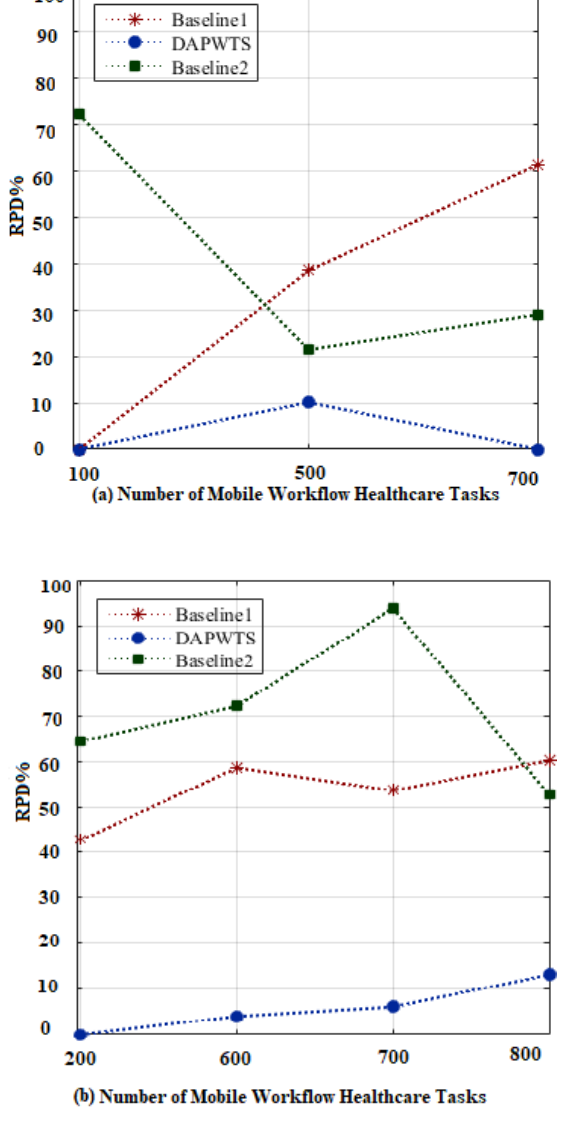
Figure 9. Multiple workflow application energy consumption at local